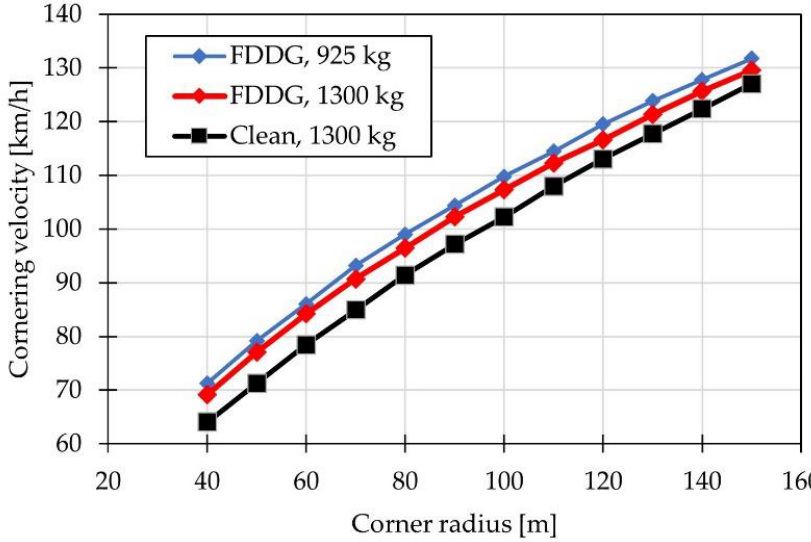
Figure 35. Comparison of maximum velocity during cornering with and without FDDG.